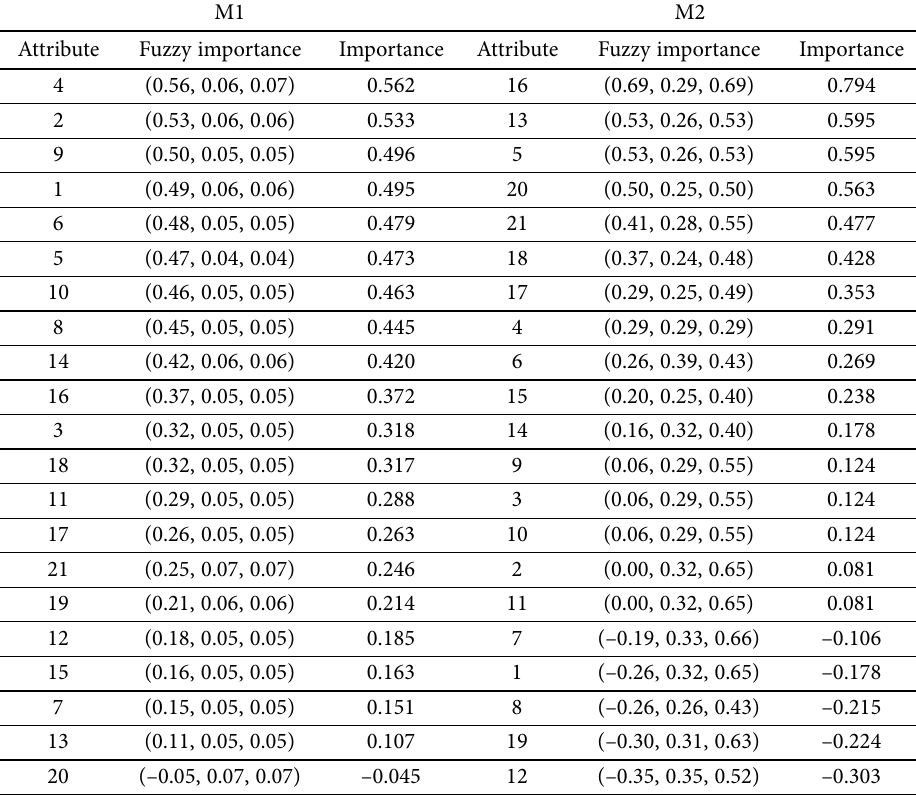
Table 17. Fuzzy importance and crisp importance of attributes related with the motivation – All hotels M1 M2